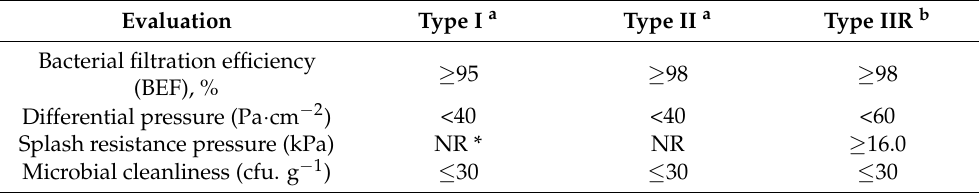
Table 5. Demands for the excepted performance of medical face masks (EN 14683:2019+AC:2019).